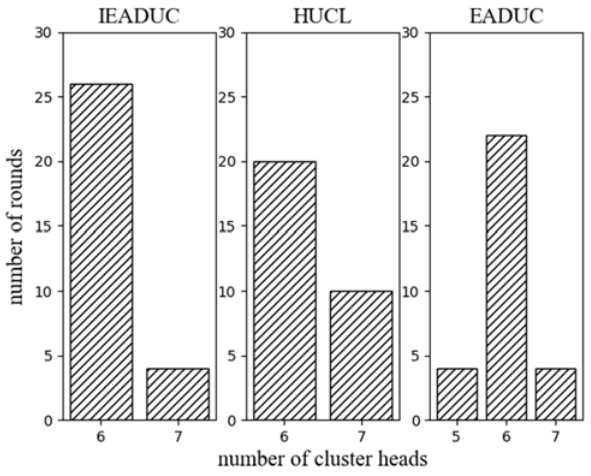
Figure 9. Distribution of the number of cluster heads.